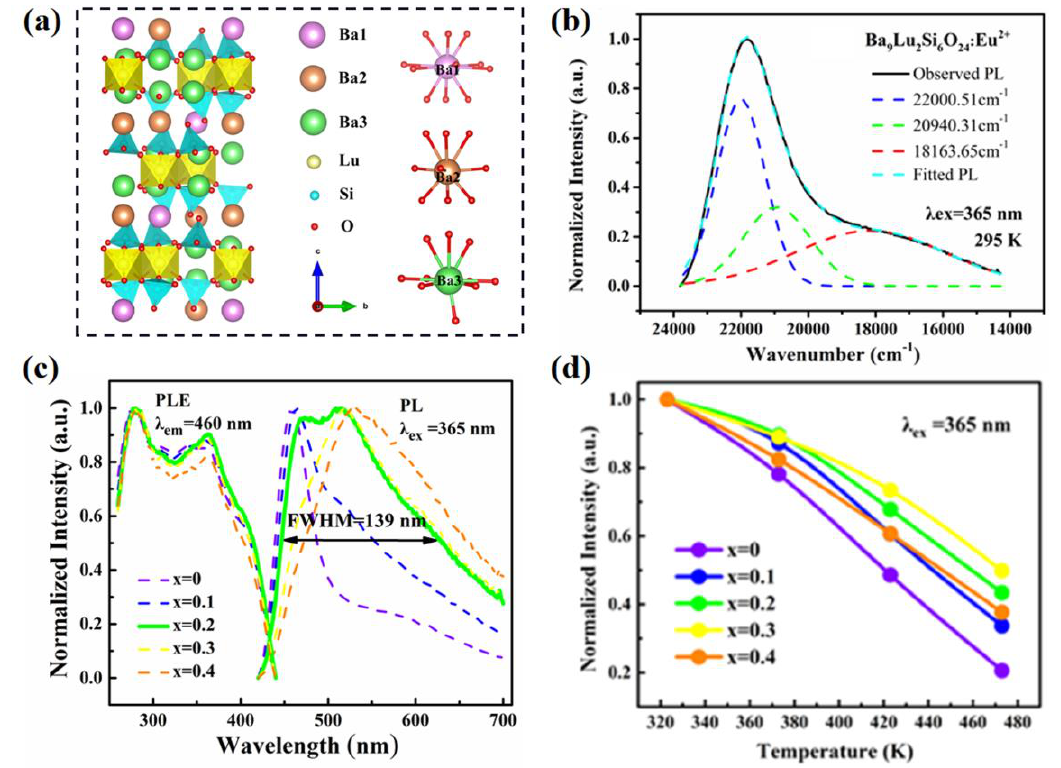
Figure 3. ( a ) Crystal structure of Ba 9 Lu 2 Si 6 O 24 and the coordinated environment of Ba1, Ba2, Ba3 and Lu. ( b ) Normalized emission spectrum and Gaussian fitting spectra excited at 365 nm of Ba 9 Lu 2 Si 6 O 24 :Eu 2+ sample at 295 K. ( c ) Normalized emission spectra (λ ex = 365 nm), excitation spectra (λ em = 460 nm) and ( d ) temperature-dependent intensity of emission spectra of (Ba 1 − x Sr x ) 9 Lu 2 Si 6 O 24 :Eu 2+ (x = 0, 0.1, 0.2, 0.3 and 0.4) samples at 295 K. Reprinted with permission from ref. [26]. Copyright 2022 American Chemical Society (New York, NY,